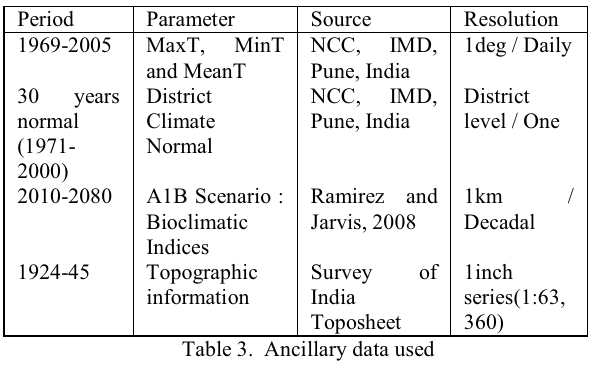
Table 3. Ancillary data